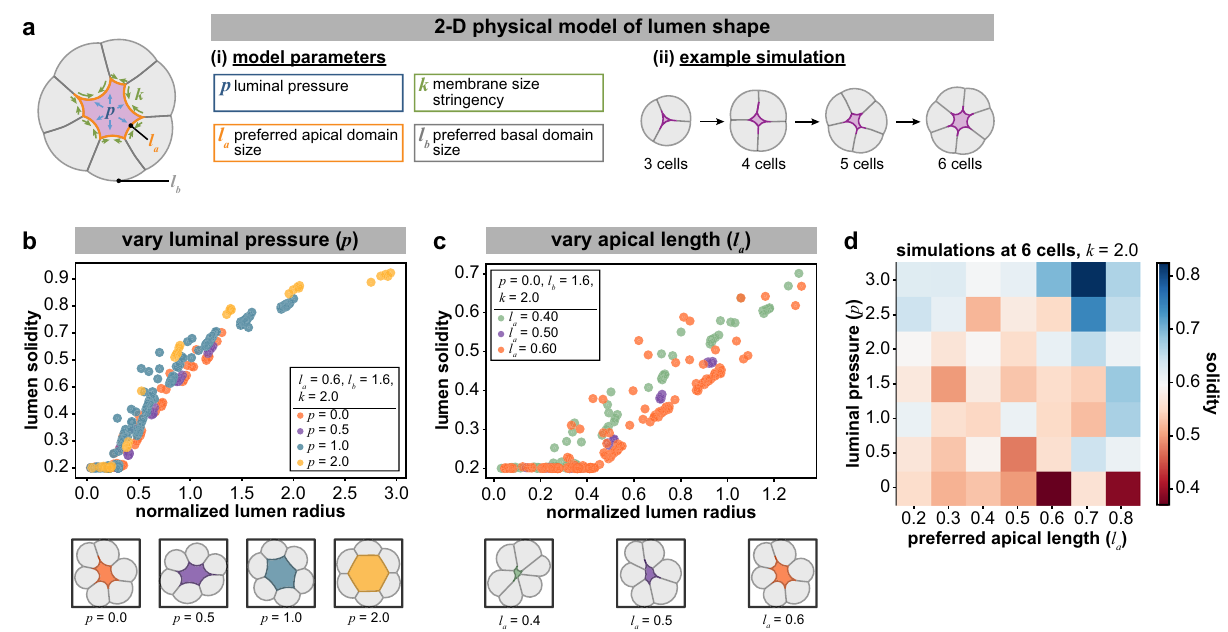
Fig. 5 A two-dimensional physical model of lumen shape. a Schematic depicting the parameters of a vertex-based model describing lumen shape. b , c Plots of solidity as a function of normalized lumen radius from simulations of a 2D vertex-based model, keeping preferred apical length and k fi xed ( l a = 0.6, k = 2.0) while varying luminal pressure ( p = 0.0 – 2.0) ( b ), and keeping luminal pressure and cell cortical tension fi xed ( p = 0.0, k = 2.0) while varying preferred apical length ( l a = 0.4 – 0.6) ( c ). Below plots, representative outputs of simulations as indicated grown to six cells. d Heatmap of mean solidity for outputs of simulations while varying luminal pressure and preferred apical length. Source data are provided in the Source Data fi